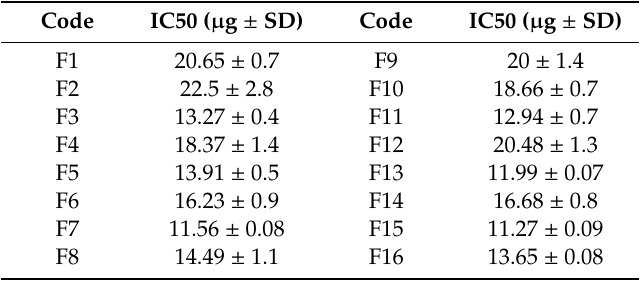
Table 4. IC50 of di ff erent PP loaded PCL nanoparticle batches after incubation with WI-38 cells for 48 h.